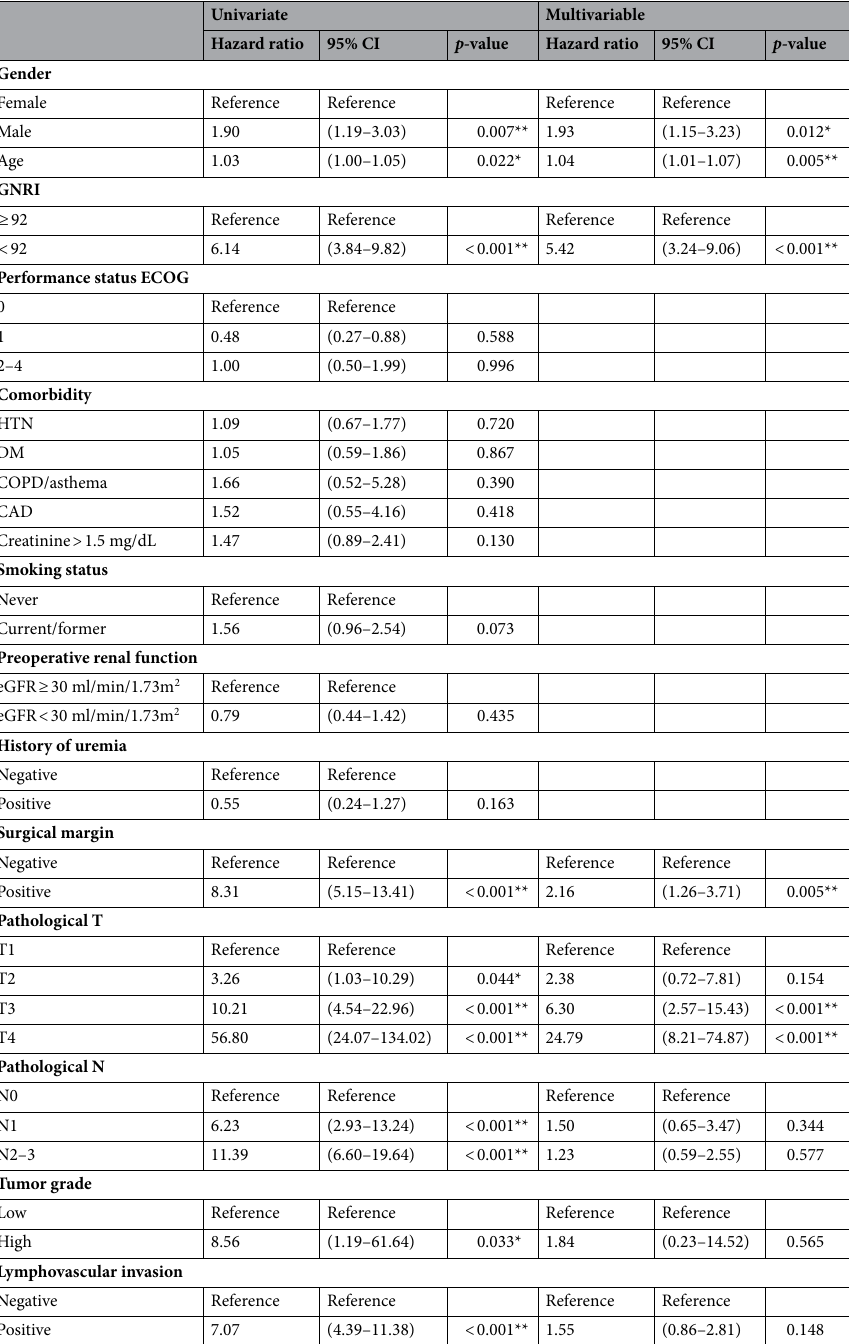
pulmonary disease, CAD coronary artery disease, eGFR estimated Glomerular filtration rate. Cox proportional hazard regression. * p < 0.05, ** p <